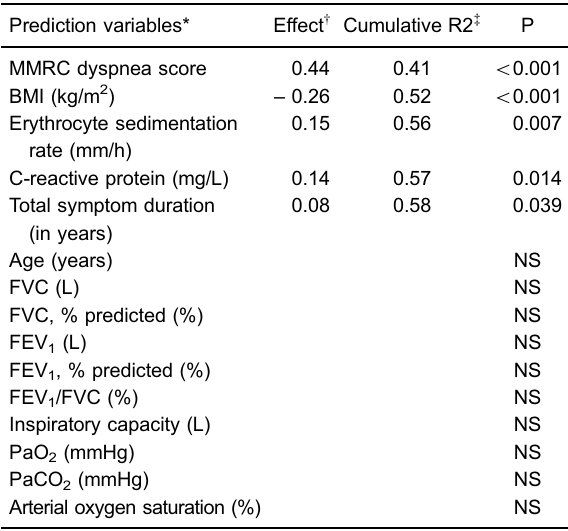
Table 4. Stepwise regression analysis to assess independent predictors of risk of